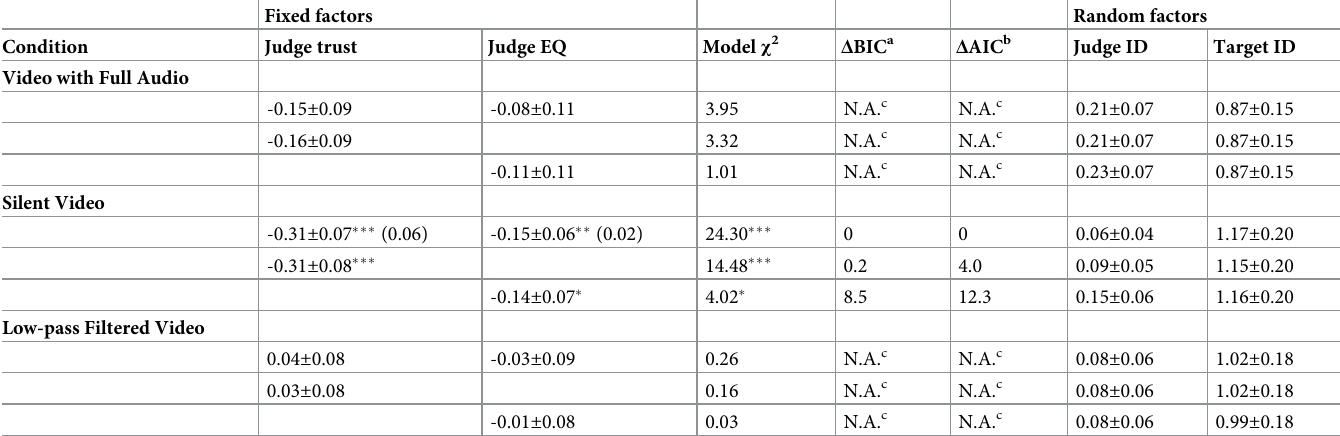
Table 10. Multilevel mixed regression models predicting LORP-LSRP standard difference score for primary psychopathy. Fixed factors